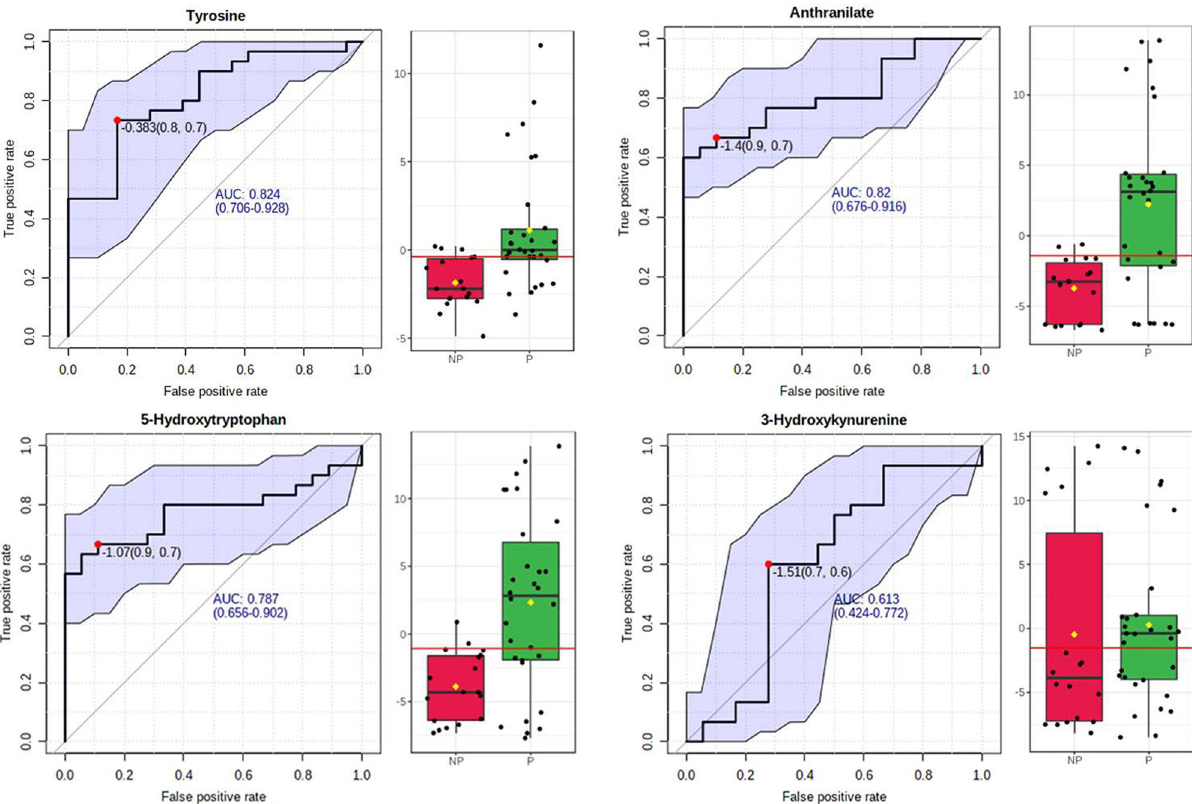
Figure 7. The predictive ability of the individual potential biomarkers based on ROC AUC values along with with Sensitivity and Specificity at 95% CI. The black dots in the boxplot of the selected metabolite (at right side) represented its’ concentrations in all samples. The notches indicated difference in the selected metabolite concentration between the groups; if the notches did not overlap, the medians were likely different. The mean concentration of each group was denoted with a yellow diamond over lying on the respective notch. The optimal cutoff was indicated with a horizontal red line on the boxplot.